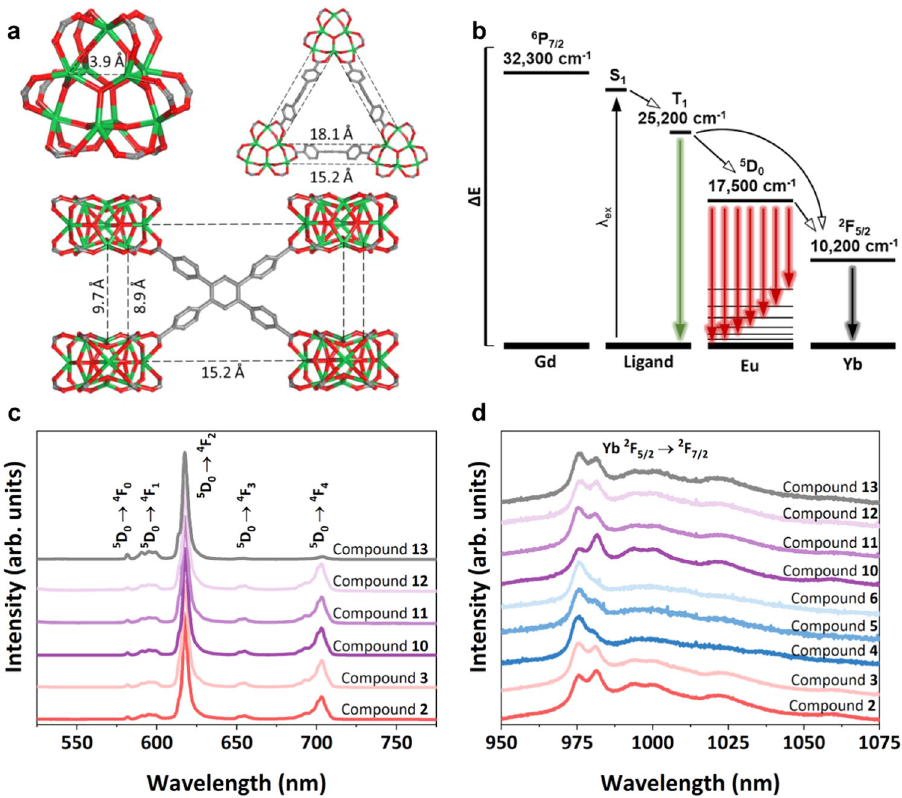
Fig. 3 | Detailed MOF structural information and photophysical properties evaluation of the rare-earth MOF family. a Ball-and-stick representation of MOF structure showing the intra-cluster and inter-cluster intermetallic distances in compound 1 , EuTCPB. Atom color scheme: C gray, O red, Yb green. H atoms are omittedforclarity. b Energytransferdiagramillustratingtherelationshipsbetween each component of the compounds reported here when the ligand is excited